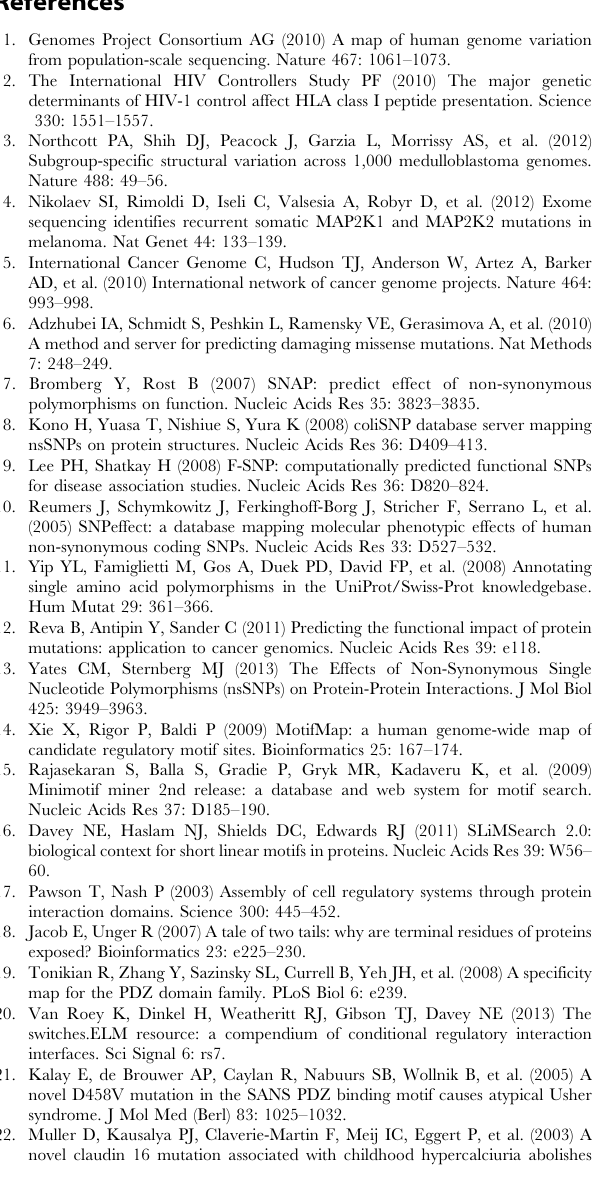
Table S3 List of C-terminal sequences with nsSNPs resulting in STOP codons and predicted to disrupt or create PDZ binding